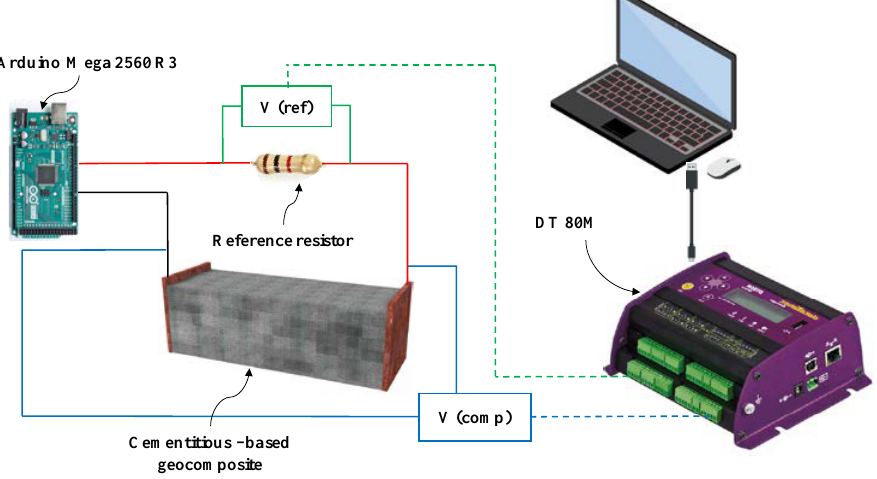
Figure 4. Experimental test configuration for electrical resistance measurement.